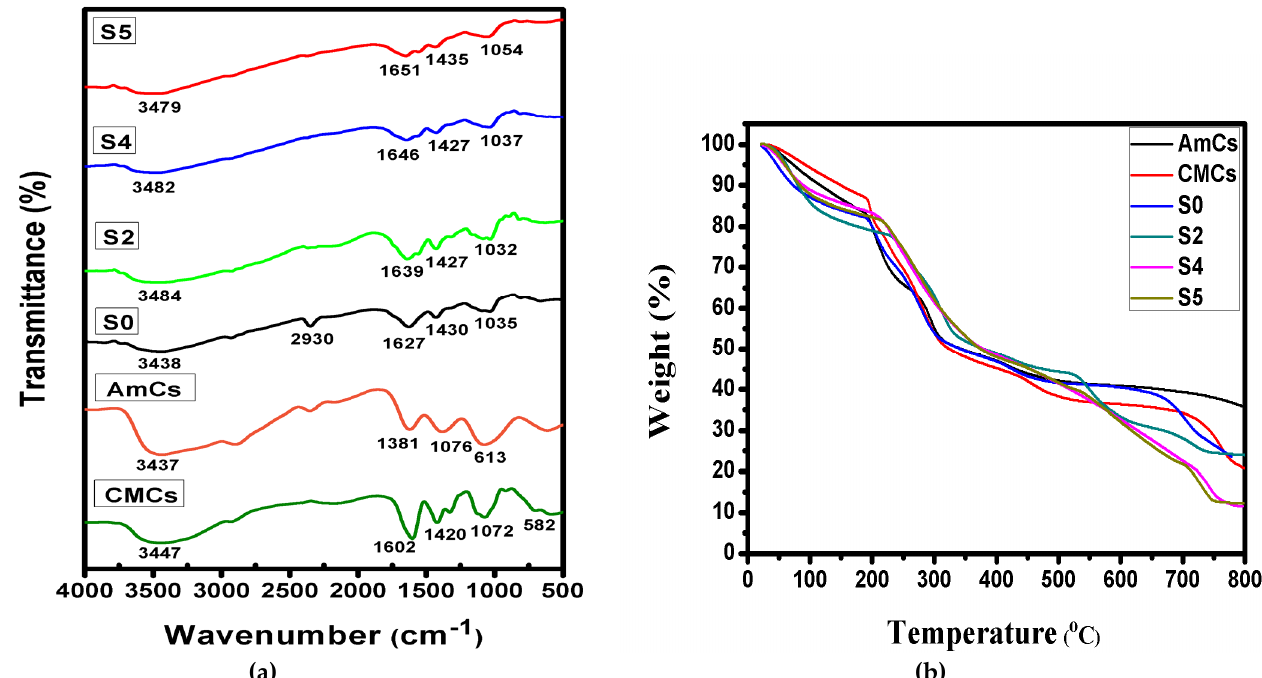
Figure 2. ( a ) FTIR spectra and ( b ) TGA thermograms of native AmCs, CMCs derivatives, Alg (S0), Alg-CMCs (S2), and Alg-CMCs@AmCs (S4 and S5) microcapsules.